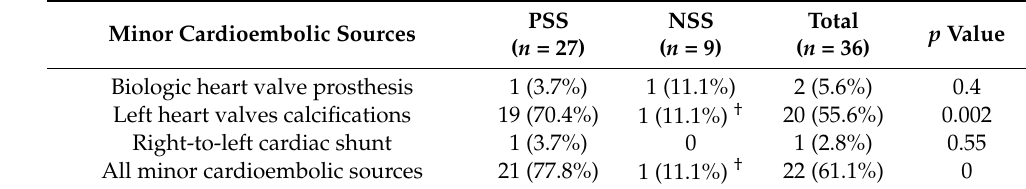
Table 4. Minor cardioembolic